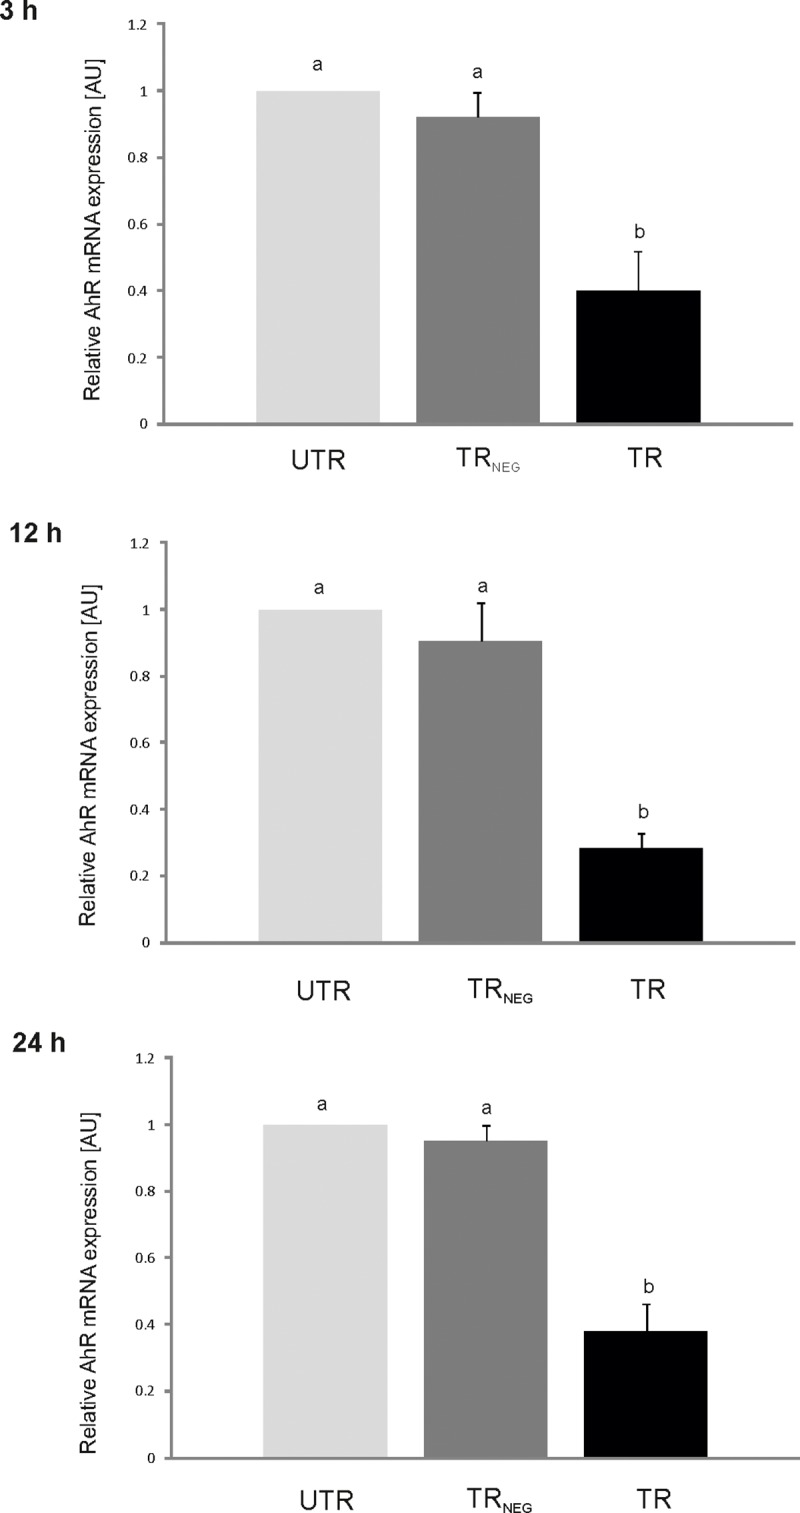
The effects of the AhR-targeted siRNA transfection on AhR mRNA expression (mean ± SEM) in porcine granulosa cells.To confirm the silencing of AhR gene in porcine granulosa cells, the expression of AhR was determined in: 1/ untransfected (UTR) cells, 2/ cells transfected with irrelevant siRNA sequence (TRNEG) and 3/ cells transfected with the three relevant siRNAs (TR). After 24 hours of incubation (with pure medium, medium with irrelevant siRNAs or medium with relevant siRNAs), cells were cultured for 3, 12 or 24 h (four biological replicates/time point). AhR mRNA expression level was examined by qRT- PCR and expressed as arbitrary units (AU). mRNA expression level in UTR group was considered as “1”, and the mRNA expression level in TRNEG and TR groups was expressed as a fraction of the UTR value. Stasistical analysis (one-way ANOVA followed by Tukey test) was performed on raw data. Different superscripts designate statistical significant differences (p<0.05) between untransfected UTR, TRNEG and TR groups.